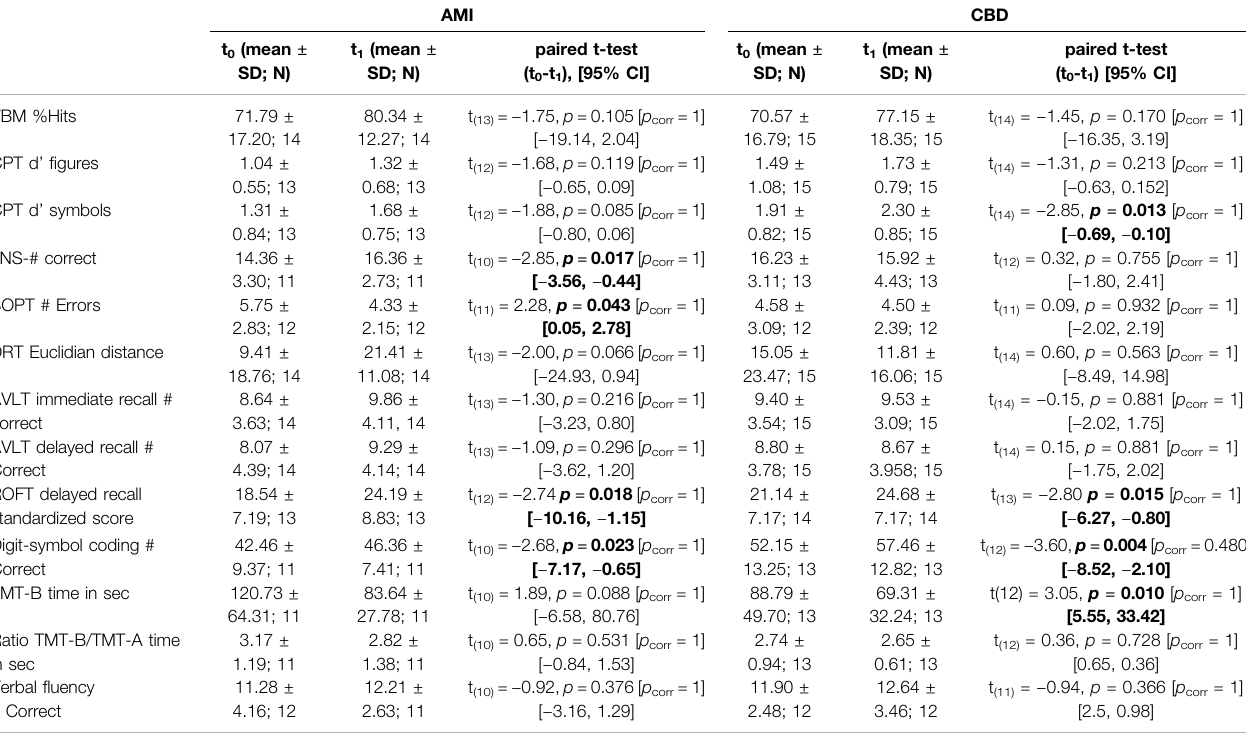
TABLE 2 | Changes in neurocognitive performance (raw score means ± SD) before (t 0 ) and after (t 1 ) intervention. Statistical signi fi cant changes (p ≤ 0.05) are indicated in bold. AMI CBD t 0 (mean ± SD;